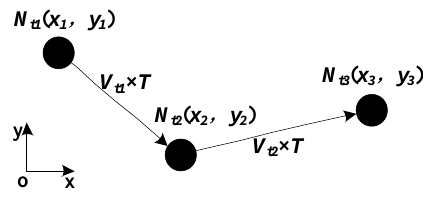
Figure 4. The calculation of beacon nodes' velocity.